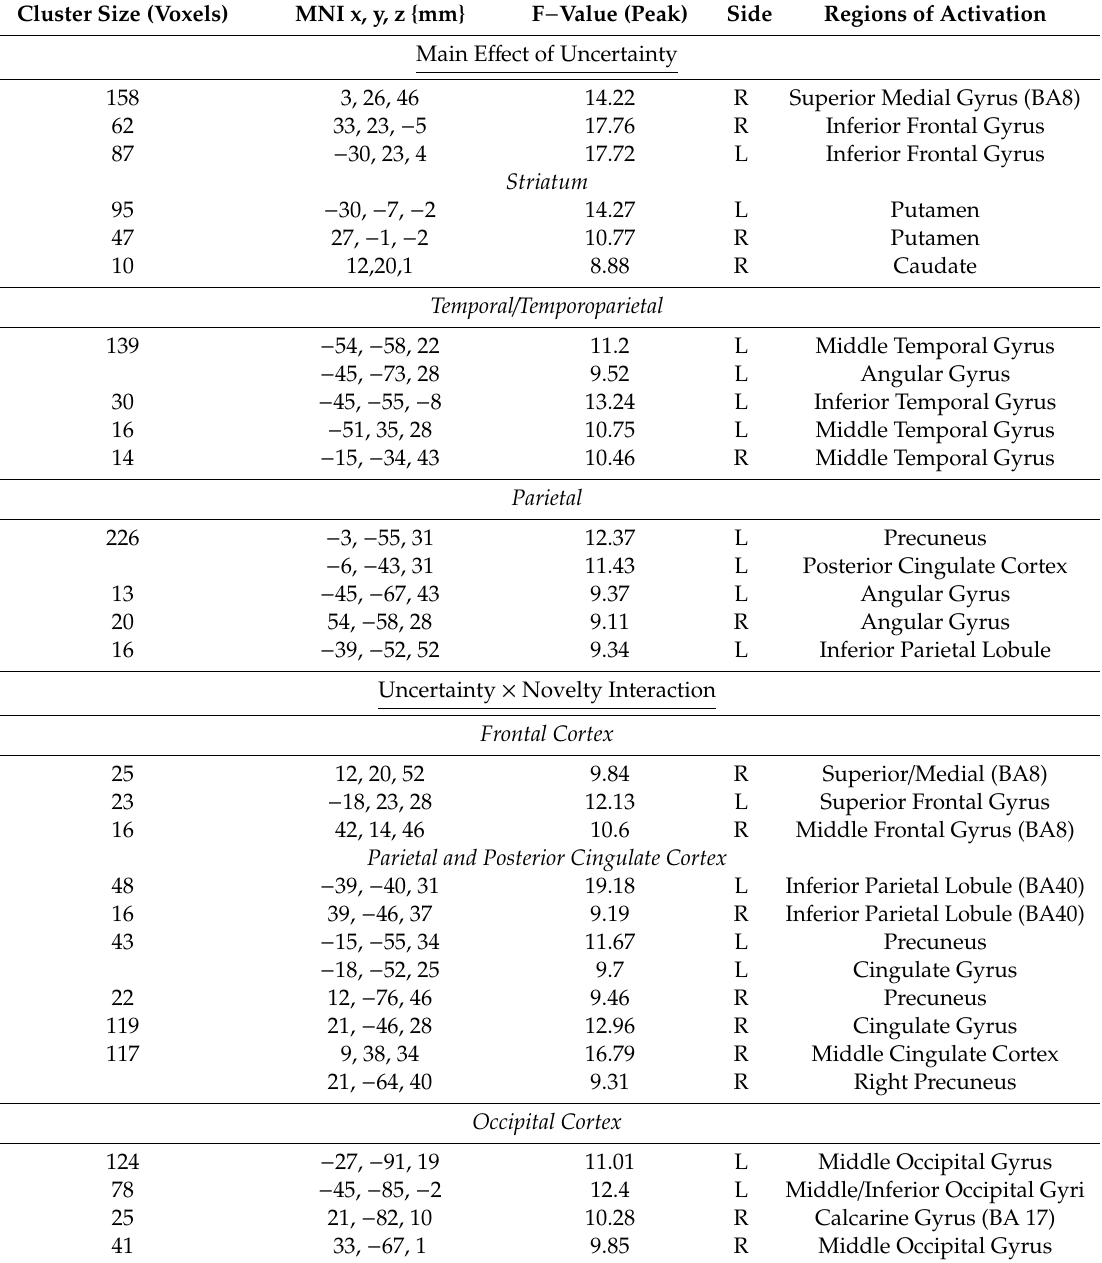
Table 2. ANOVA for the conjunction analysis: main e ff ect of uncertainty and uncertainty × novelty interaction 1